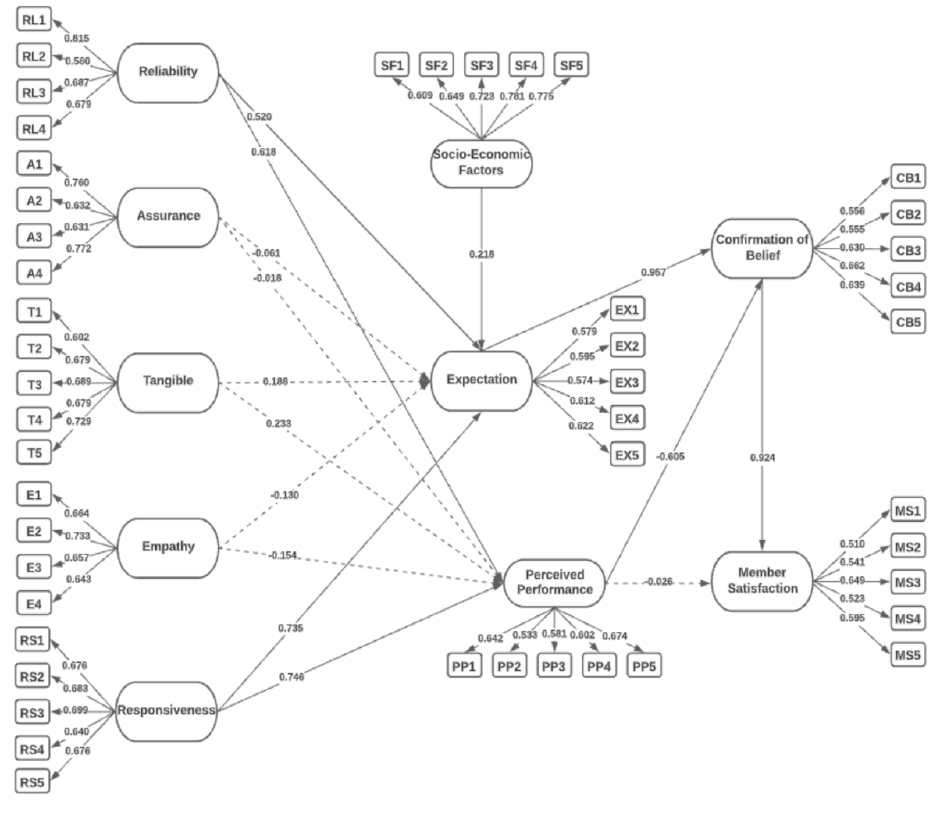
Figure 4. Initial SEM Model for determining the Members’ Satisfaction towards PhilHealth.